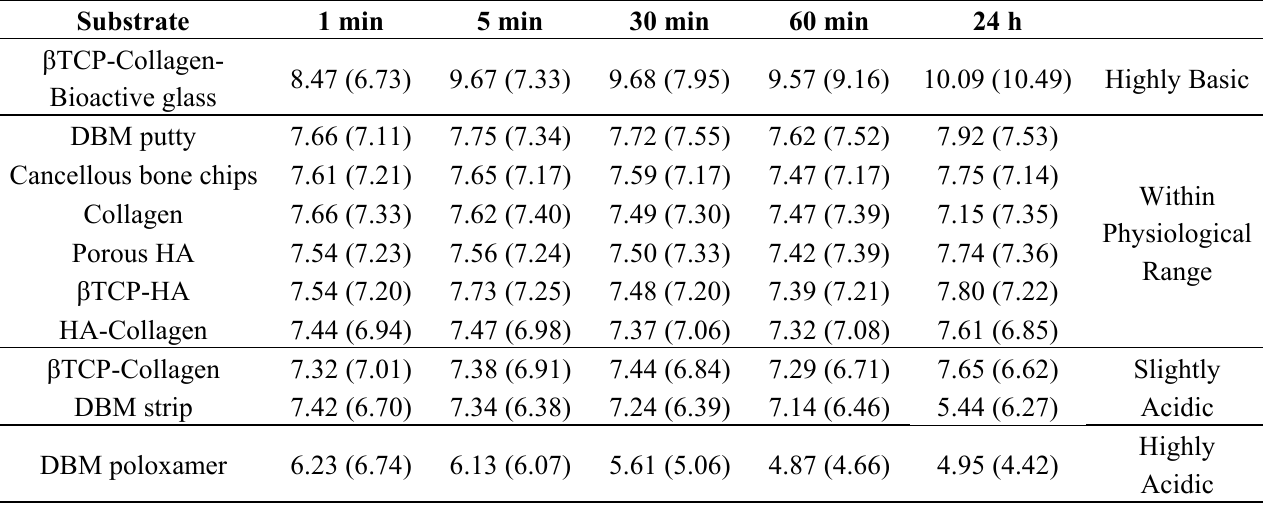
Table 2. Average pH values of substrates buffered in human plasma over 48 h (pH values in phosphate buffered saline in